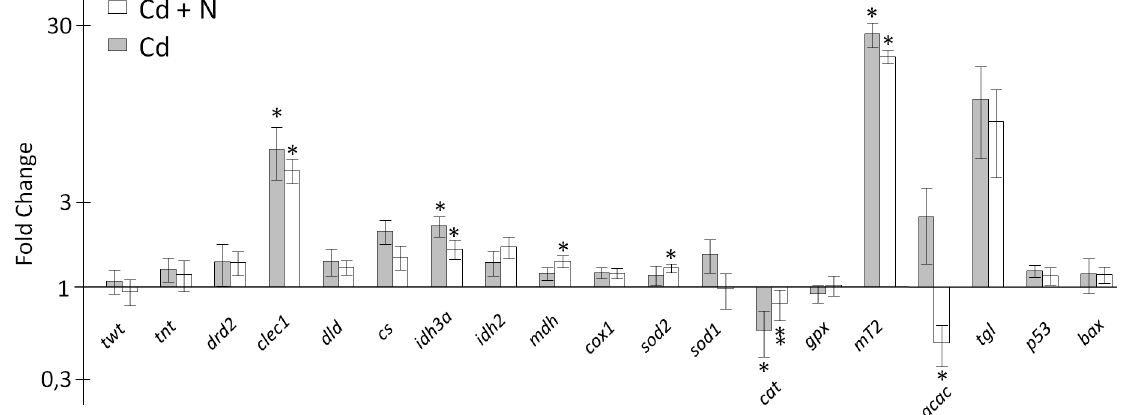
Fig 4. Transcriptional variations of selected genes in the gills of oysters M . gigas exposed to Cd plus cargo ship noise or Cd alone for 14 days. (cid:3) and (cid:3)(cid:3) denote significant differences between the condition and the control and between experimental conditions,